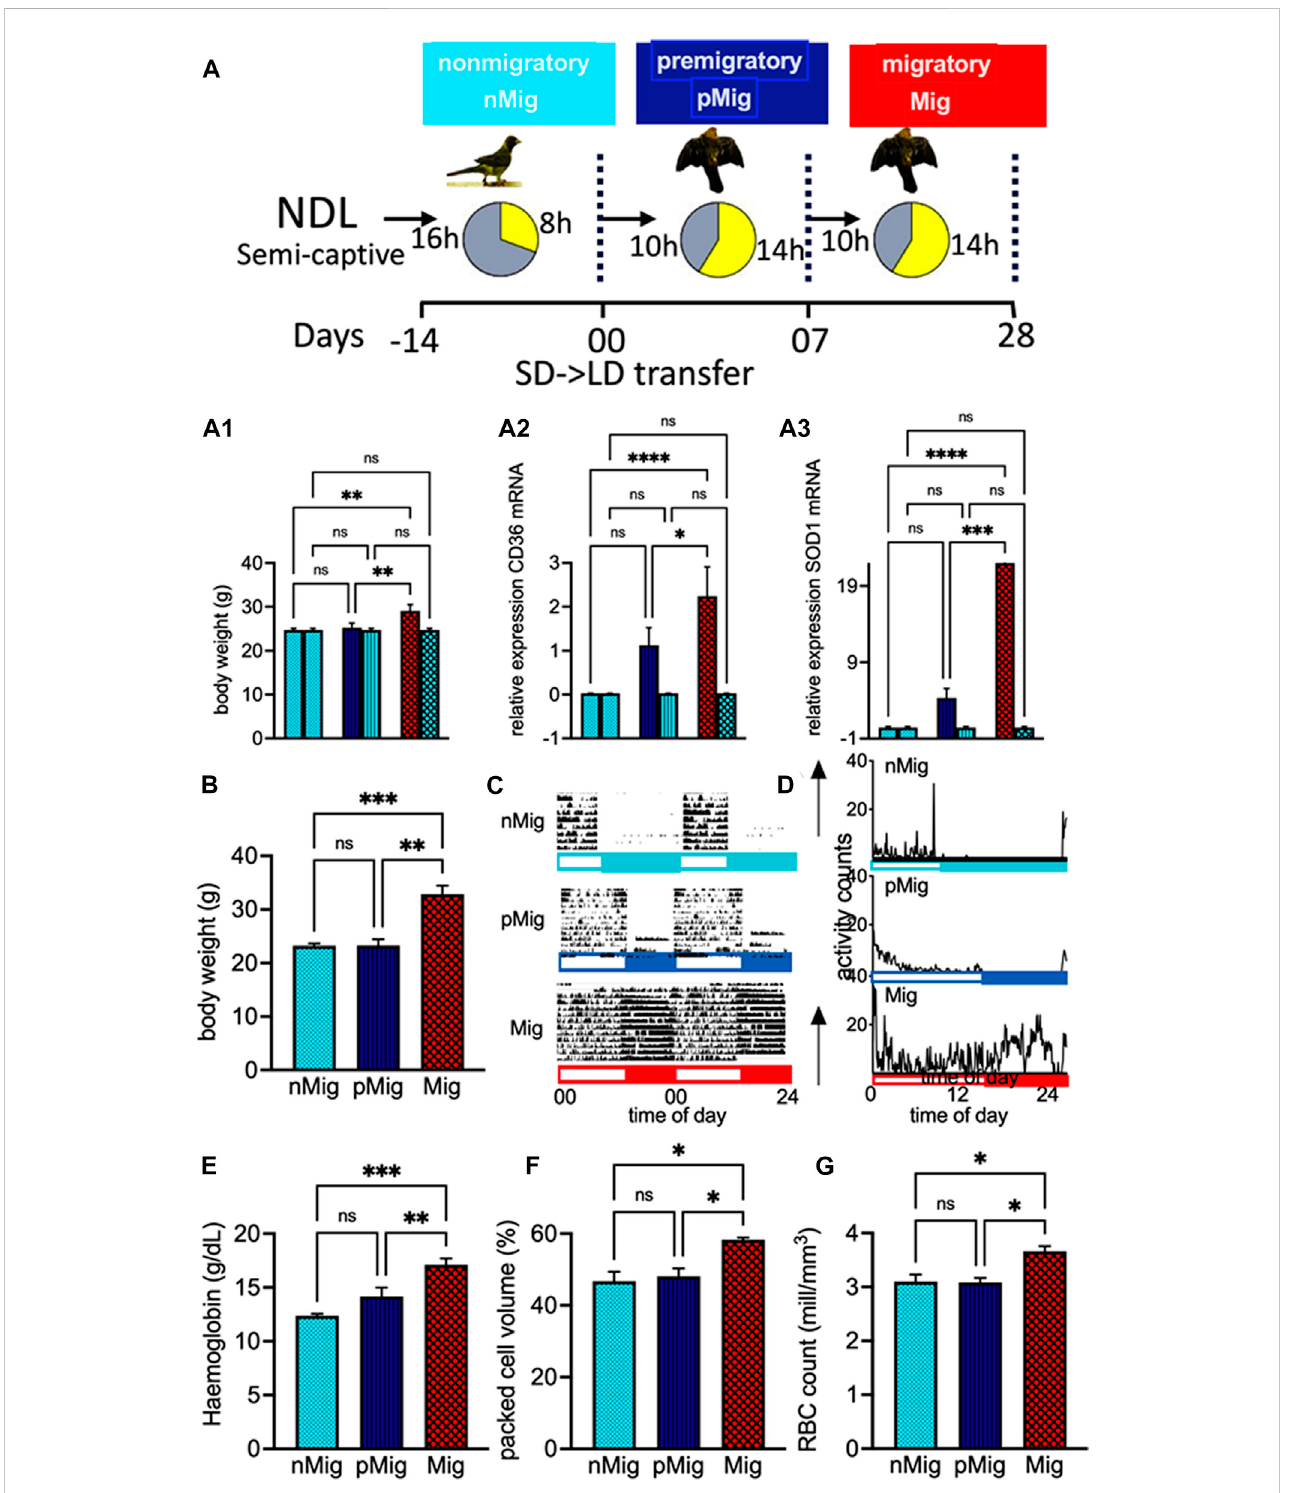
FIGURE 1 (A) Experimental design. Male red-headed buntings, Emberiza bruniceps , either in activity cages ( n = 6) or in two groups ( n = 6, each) were brought indoorsfromnaturaldaylength,NDL,conditionsduringFebruaryandplacedunderashortphotoperiodof8 hoflightand16 hofdark(SD,8L:16D)for14 days. Birdsin sixactivity cages andone group weretransferred tolongdays (LD,14L:10D) onday0. (A.1 – A.3) Comparisonof bodyweight(g)and mRNA expression of CD36 and SOD1 of groups 2 and 3, the latter continuously held under SD. Buntings exhibited non-migratory ( nMig , cyan blue), pre-migratory ( pMig , blue), and migratory ( Mig , red) annual life history states, on days 0, 7, and 28 of blood sampling. (B) Mean (±SEM) of body weight of nMig , pMig , and Mig buntings. (C) Double-plotted actogram representative of nMig , pMig , and Mig buntings. (D) Mean activity pro fi le of buntings ( n = 6), in Figure 1A. Open and closed bars on the X-axis show light and dark phases, respectively. (E) Mean (±SEM) of hemoglobin (g/dL), (F) mean (±SEM) of packed cell volume (%), and (G) mean (±SEM) of red blood cells in blood (millions/millimetre 3 ). Data are represented as mean ± SEM. Asterisk (*) over the line on the bar indicates a signi fi cant difference between nMig , pMig , and Mig states of buntings (* p < 0.05, Tukey ’ s